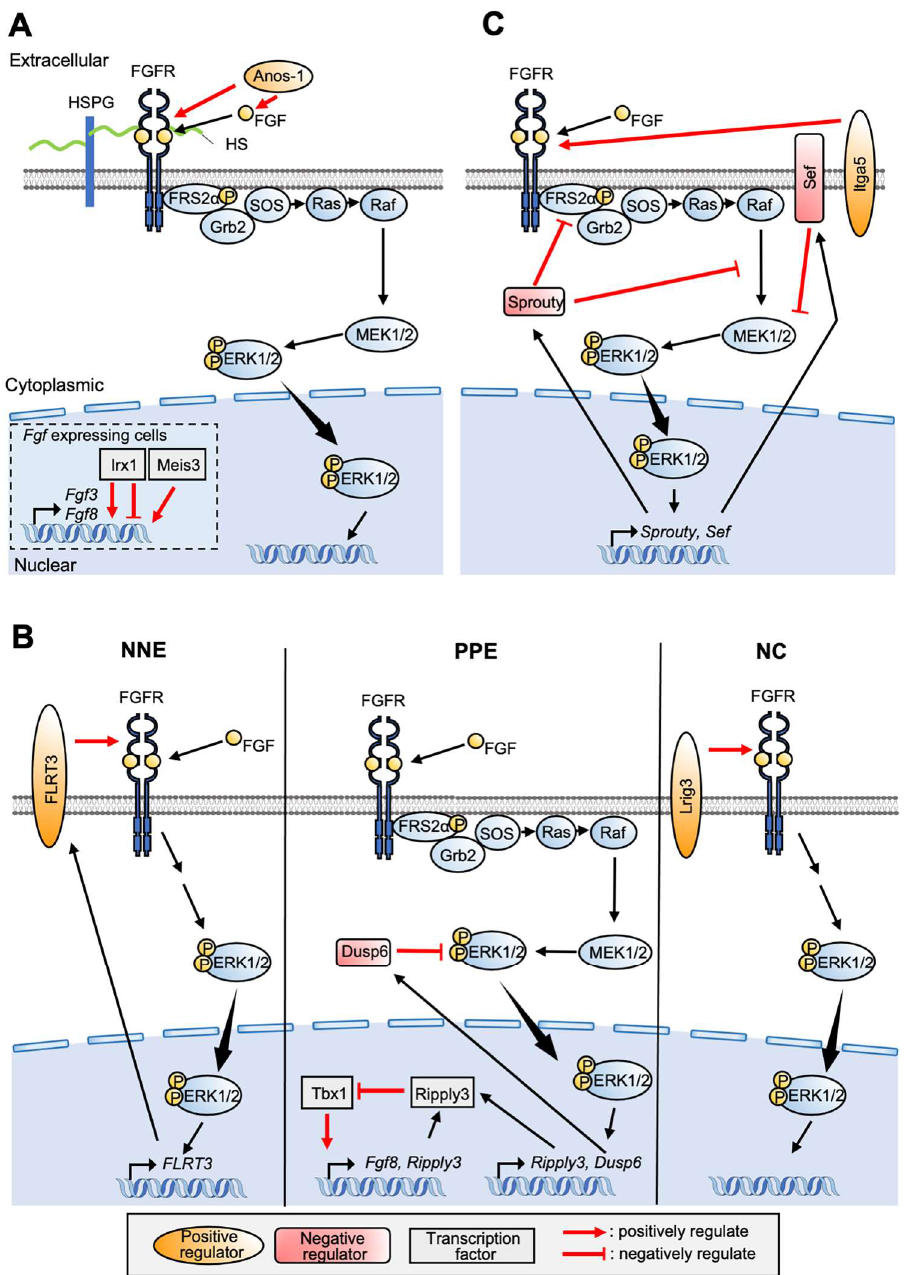
Figure 4. An outline of the FGF signaling pathway and a list of related factors described in this review: Factors involved in NPB ( A ), NC/PPE/NNE ( B ), and posterior placode ( C ) formation are shown. Properties of each factor and their actions on targets are shown by color and by arrows. Factors involved in PPE formation are shown in red or orange.